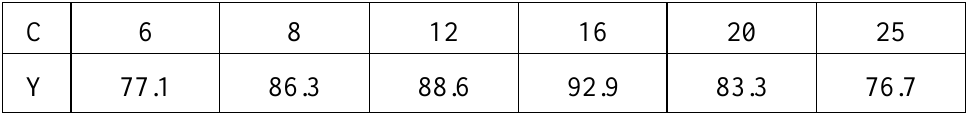
Table 5 . Influence of the reaction time (C) on